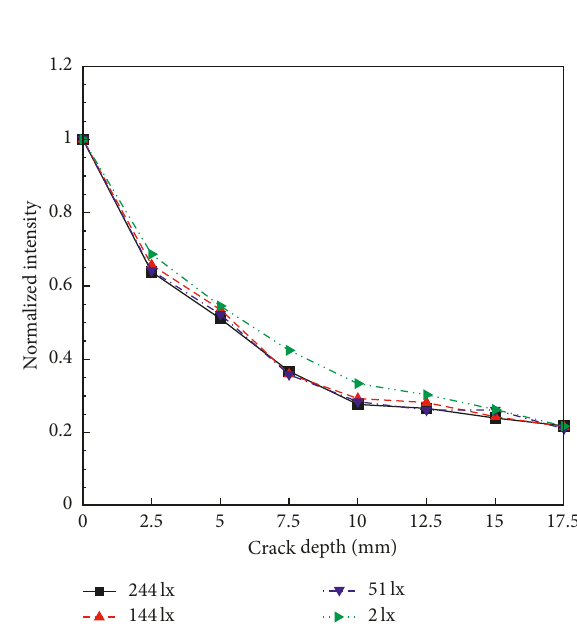
Figure 7: Intensity value under indirect lighting